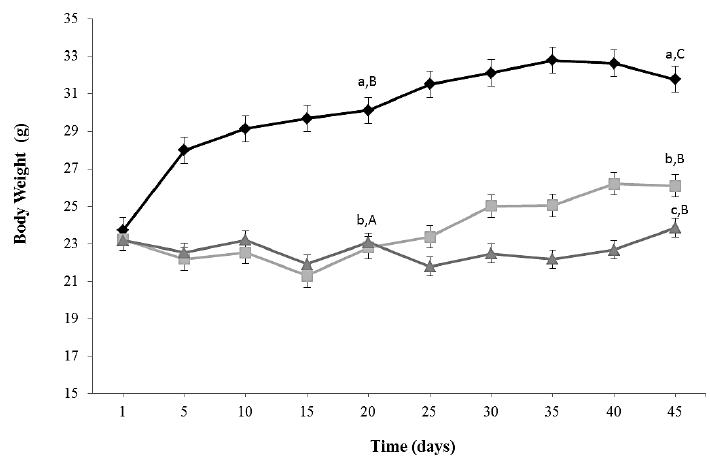
Figure 1. Body weight of ad libitum fed and caloric restricted mice: ( (cid:7) ) ALF: ad libitum fed Group; ( (cid:4) ) CR: caloric restriction Group; and ( (cid:78) ) CR-Lf: caloric restriction plus L. fermentum CRL1446 administered Group. Data are means ˘ SEM ( n = 12 per group). Data with different lowercase letters (a–c) at the same period of treatment and data with different uppercase letters (A–C) in the same group are significantly different ( p < 0.05) according to ANOVA statistical analysis.